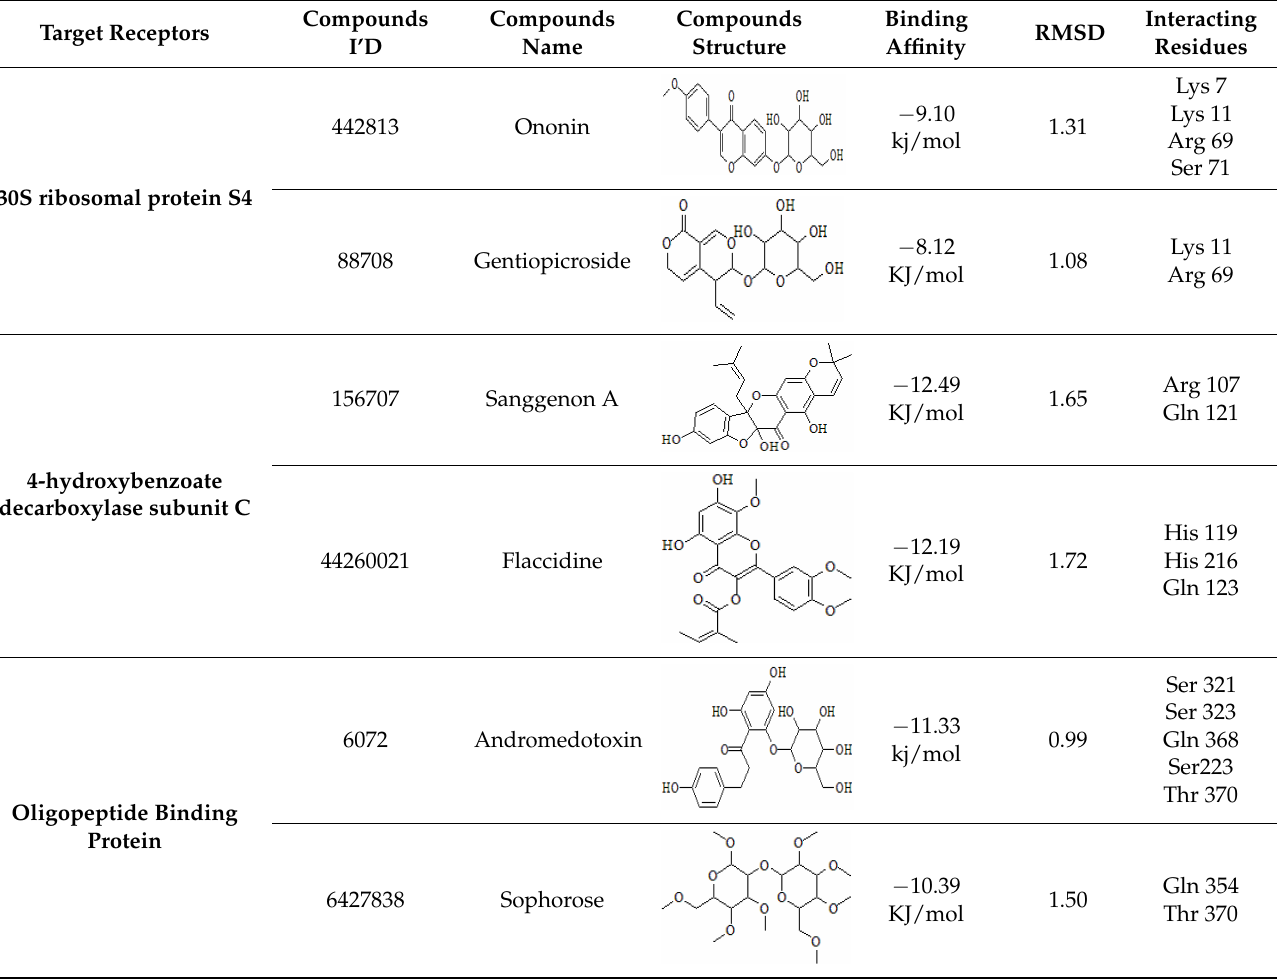
Table 3. Top drug candidates' binding affinity along with interacting